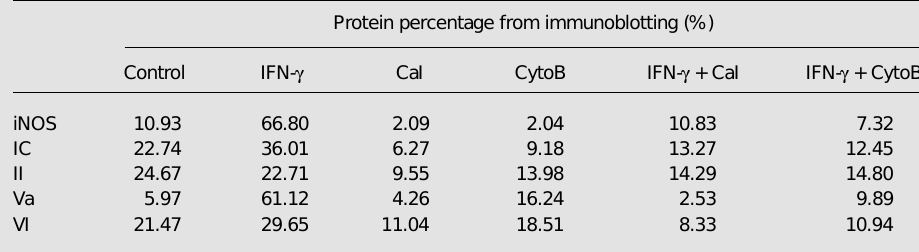
Table 1 - Densitometric analyses from Western blotting of inducible nitric oxide synthase (iNOS) and myosins IC, II, Va and VI after stimulatory or inhibitory